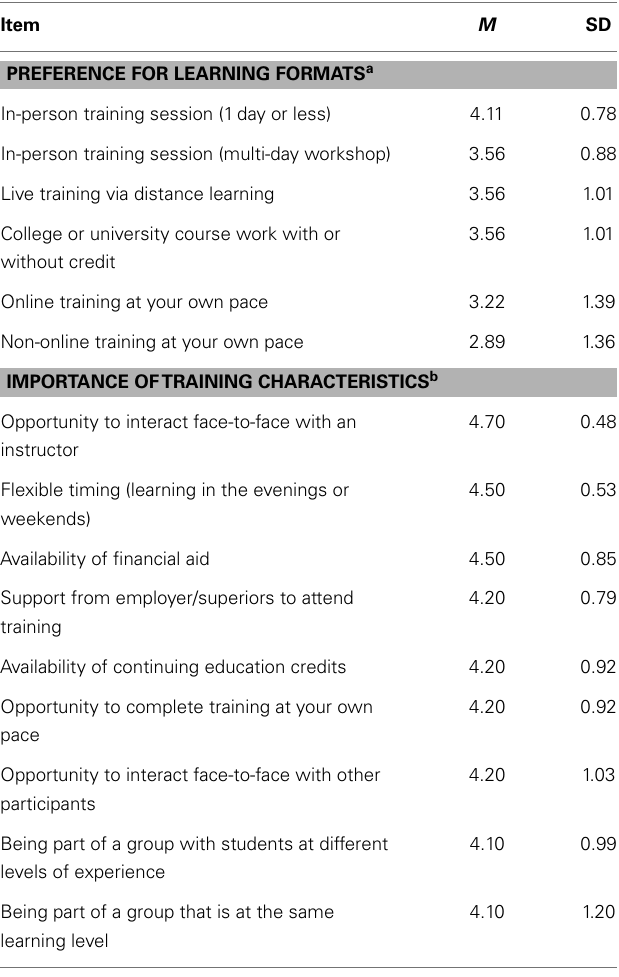
Table 2 | Preferences for learning formats and importance ratings of training characteristics .